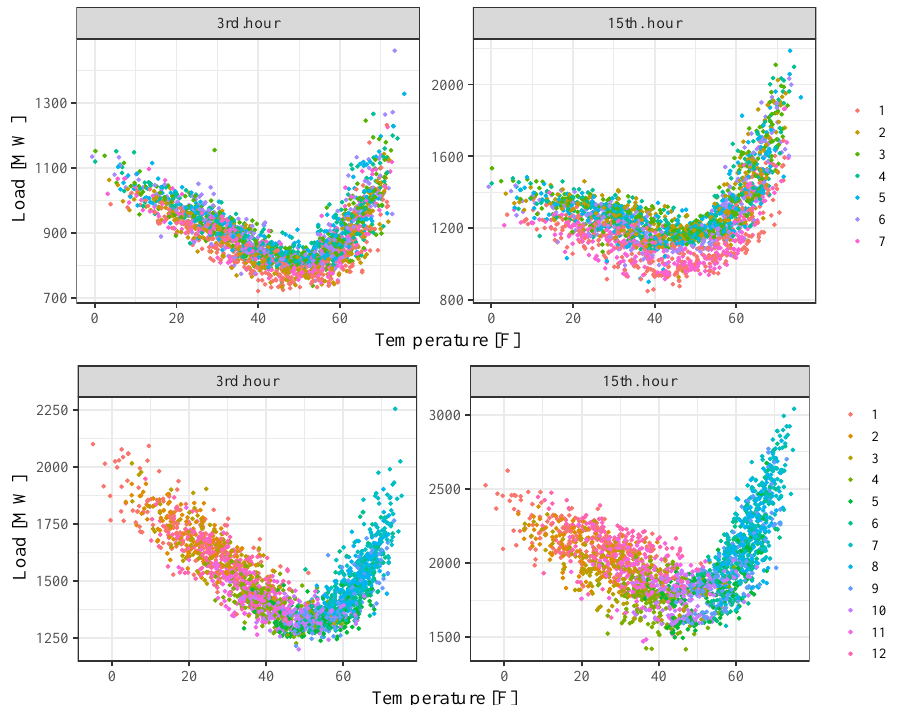
Figure 1. The differences in the load–temperature relationship between days of the week ( upper row ) and over the year ( bottom row ), for non-working ( left ) and working ( right ) hours. For available daily maximum and minimum temperature values, T mx and T mn , their com- bined effect on the load is fully represented with the separate terms f Tmx ( T mx ) , f Tmn ( T mn ) and ( T ) . For weekly and yearly change adjustments, f ( T ) interaction f T mx , T mn x , week T x , week mx , T mn ( T ) are the interactions terms, where T and f T x , year x is the maximum/minimum tem- x , year perature. With this set of terms, the overall daily weather-induced variation of the load is modeled. In order to account for the impact of the temperature history, i.e., the influence of the temperatures from previous days on current load, the same set of terms with the temperatures from the previous two days were